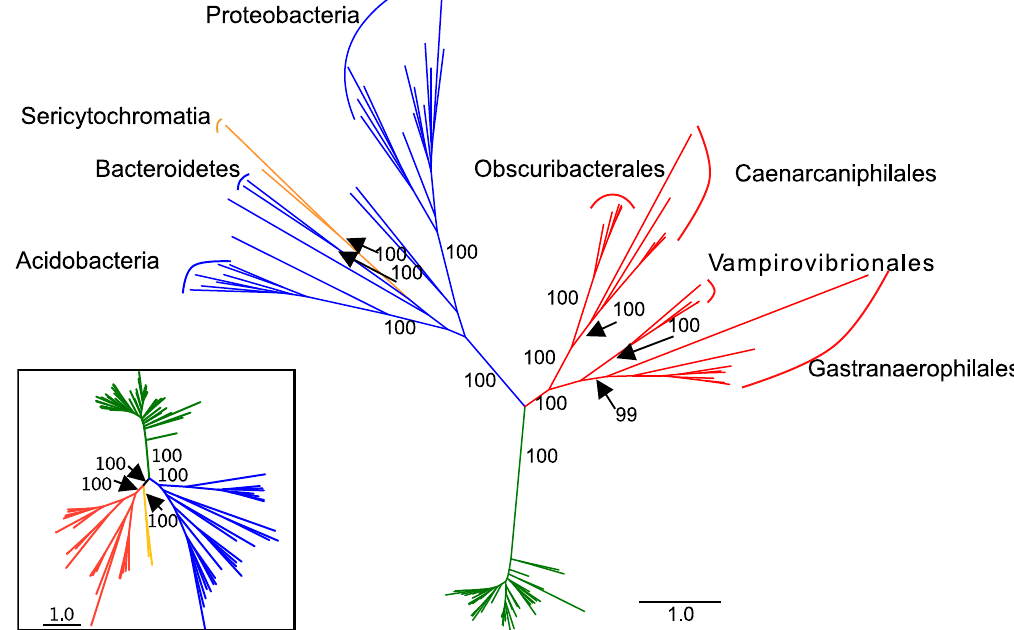
Figure 2. Maximum likelihood tree constructed from the concatenation of translated nuoA , nuoB , nuoC , nuoD , nuoH , nuoI , nuoJ , nuoK , and nuoN sequences (3358 amino acid residues). The tree contains 102 taxa. Cyanobacteria are indicated in green, Melainabacteria in red, Sericytochromatia in orange, and other groups in blue. For non-Cyanobacteria, phyla with 2 or more representatives are labeled. Order-level classifications are indicated within the Melainabacteria. Bootstrap values are indicated for labeled clades. Inset: concatenated, single-copy phylogeny containing only the 102 genomes used to construct the concatenated tree in the main figure.